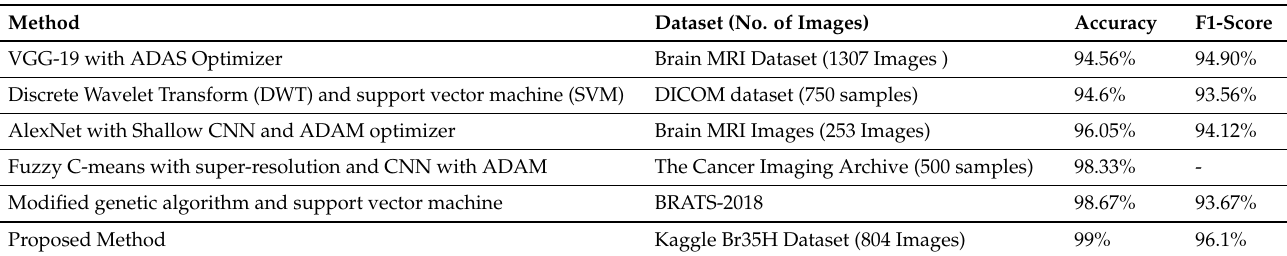
Table 5. Comparative result